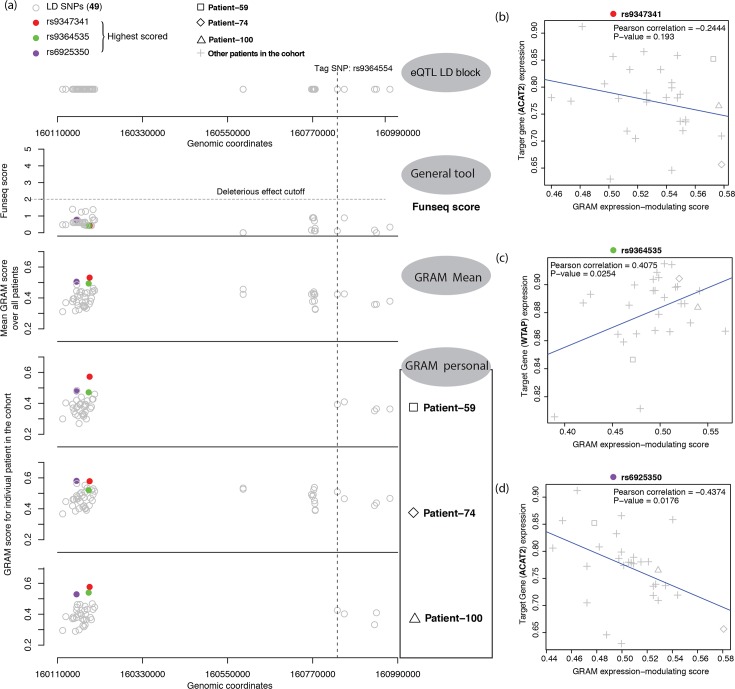
Fine mapping of variants in prostate cancer.(a) General pipeline of the fine-mapping analysis. The first panel shows the position of the variants in the LD block (chr6:160081543–161382029, tag SNP rs9364554). The second panel shows the FunSeq scores of these variants, where little variation and significance is observed. The third panel shows the average GRAM score over the patients, with three highest-average-scored variants labelled in specific colors. Personalized GRAM scores for the three highest-scored variants in three selected patients are presented subsequently. (b) ~ (d) Correlation between the GRAM score of variants with high scores and the expression of relative target genes.